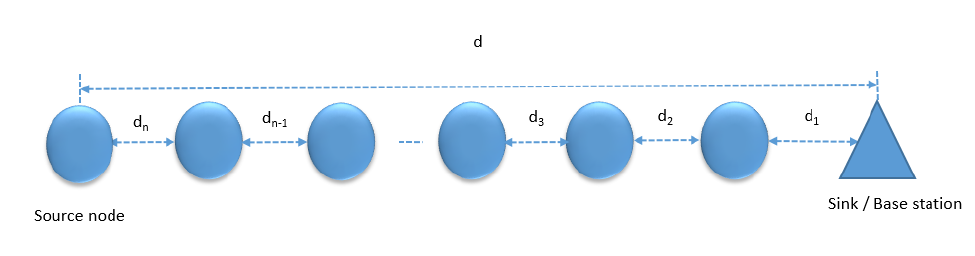
Figure 8. Multi-hop WSN model.